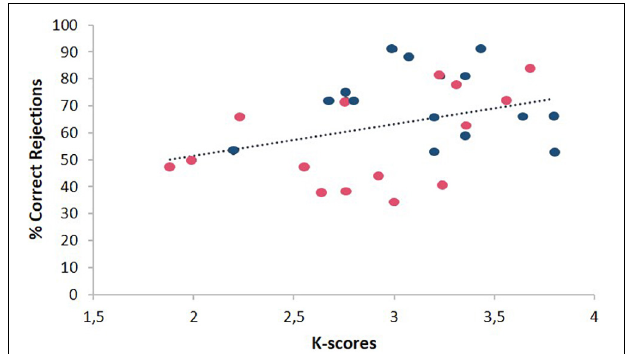
FIGURE 4 | Dispersion of mean percentage of Correct Rejections in Position trials in the Spatial Memory Task due to the K-index. Blue point (male), red point